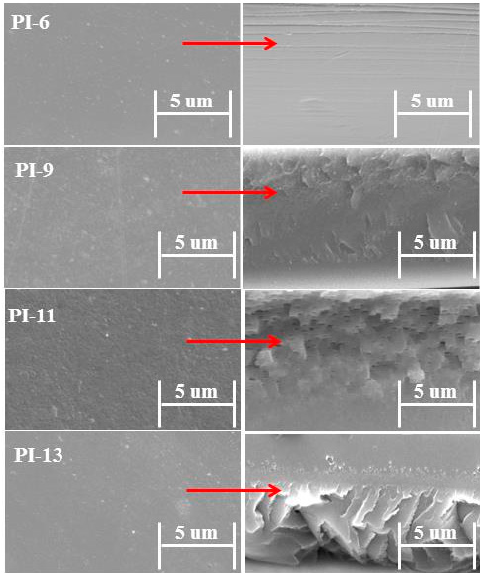
Figure 6. SEM micrographs of surface section (on the left ) and cross-section of the AEMs with increasing amounts of PI (on the right ).